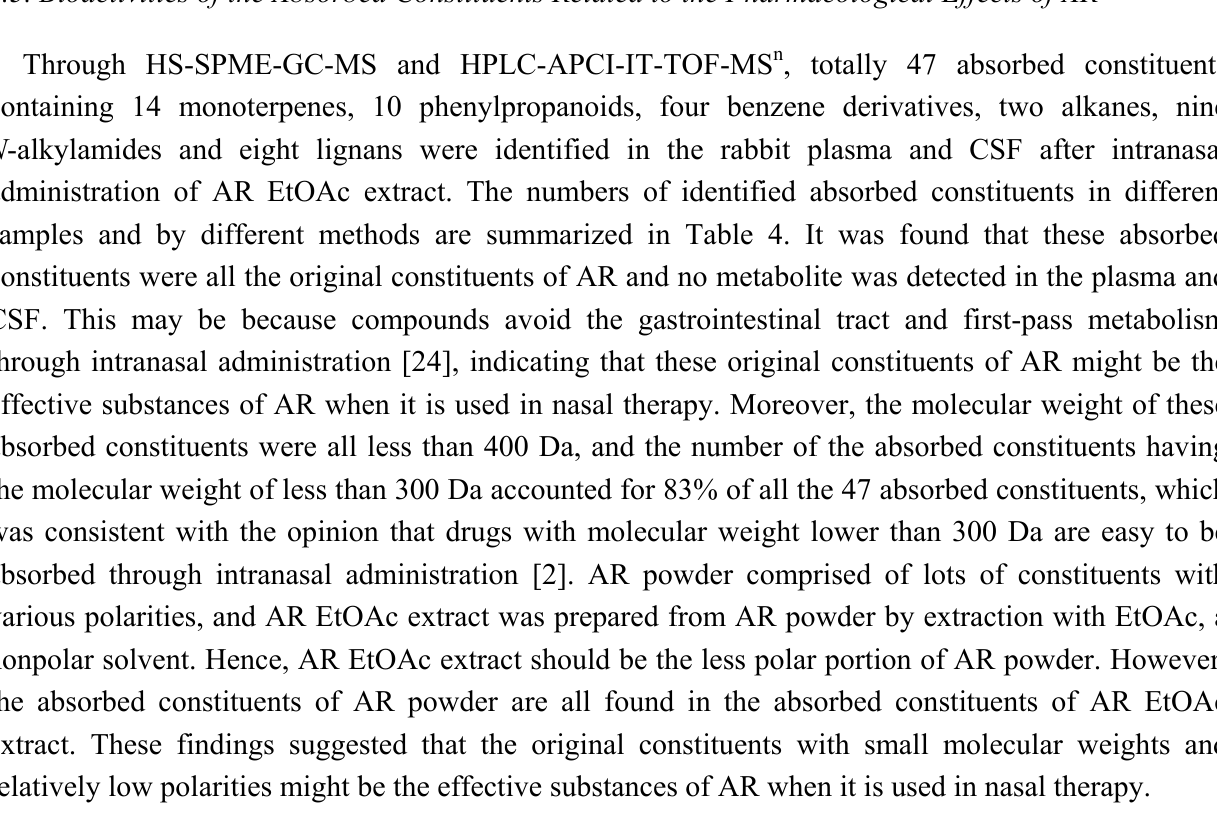
Table 4. The numbers of identified absorbed constituents in plasma and CSF of AR EtOAc extract group rabbits by HS-SPME-GC-MS and HPLC-APCI-IT-TOF-MS n . Same Constituents Identified by GC-MS LC-MS GC-MS and LC-MS Plasma 25 23 CSF 25 Same constituents in 24 ( G1 – G13 , 5 ( L6 , L7 , plasma and CSF G15 , G17 – G26 ) Total